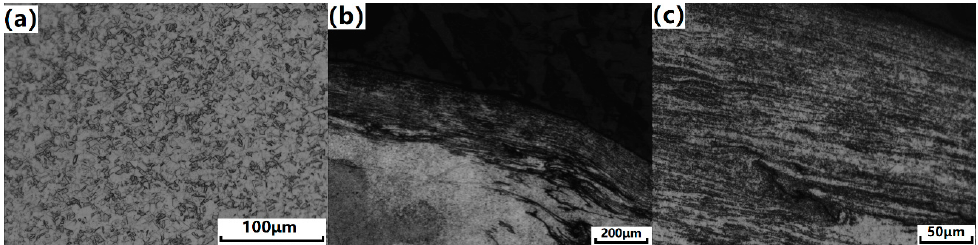
Figure 3. Optical microstructures of the Cu-Mg alloy at ( a ) the as-conformed state; ( b ) and ( c ) are the conform + surface nano-crystallization (SNC) alloy at low and high magnification, respectively.